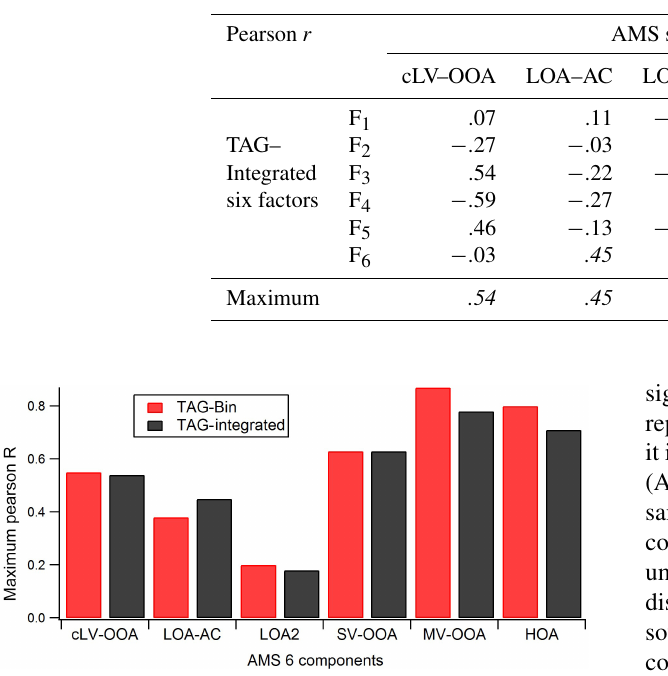
Table 3. The correlation coefficient r of factors’ time series of the PMF six-factor solution between AMS and TAG–Integrated. The TAG– Integrated indicates the TAG integration method. The italic font represents the maximum value in each column.